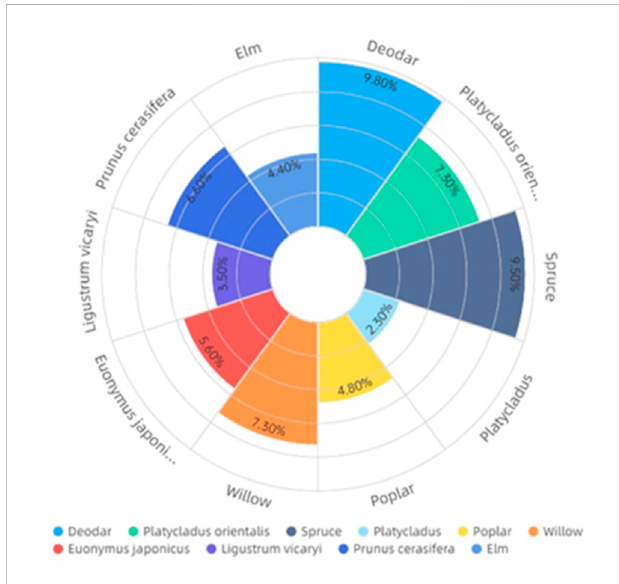
FIGURE 3 Statistical chart of commonly used arbors in Lhasa.